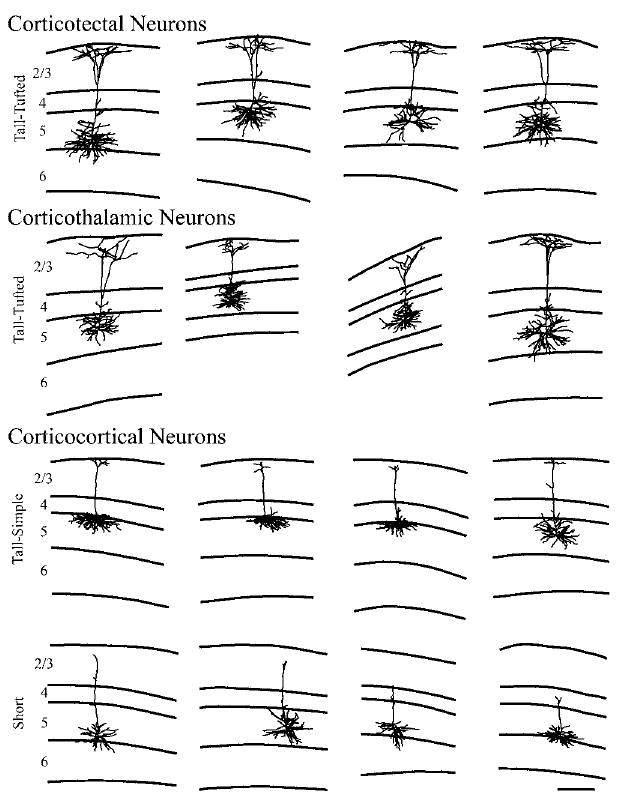
Figure 3. Representative examples of reconstructions of neurons from each injection site. Lines defi ne the laminar boundaries for each cortical layer. The upper line indicates the top of the section, with layer 1 included with layer 2/3. Neurons are grouped according to injection site and cell type. The scale bar is 250 microns and applies to all drawings.